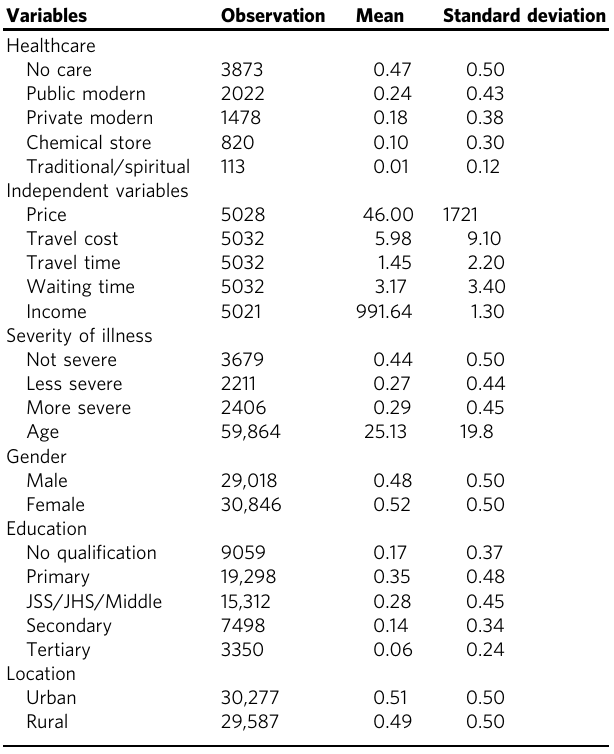
Table 2 Summary statistics of the dependent and independent variables.